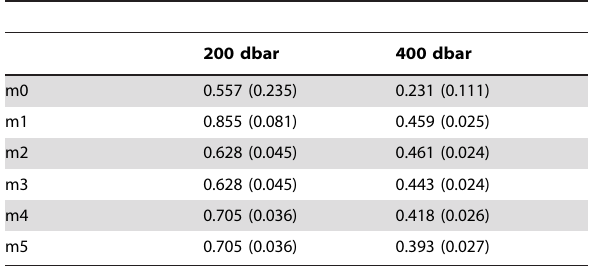
Table 3. Accumulation rates inferred from data from first 4 surveys (1992–2005).